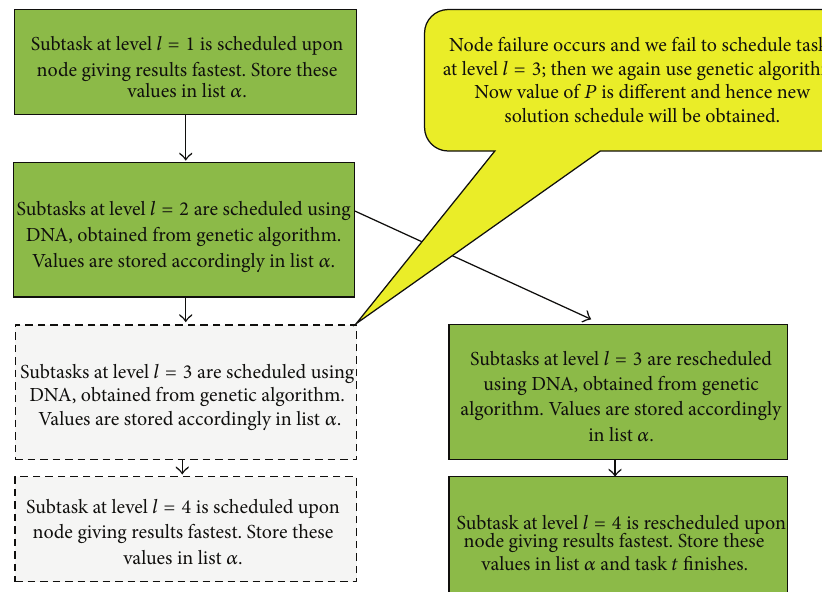
Figure 5: Working of fault tolerance in PLBGSA.